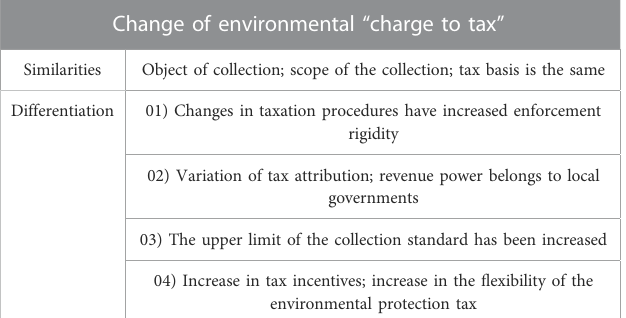
TABLE 1 Changes before and after the introduction of environmental tax. Change of environmental “ charge to tax ” Similarities Object of collection; scope of the collection; tax basis is the same